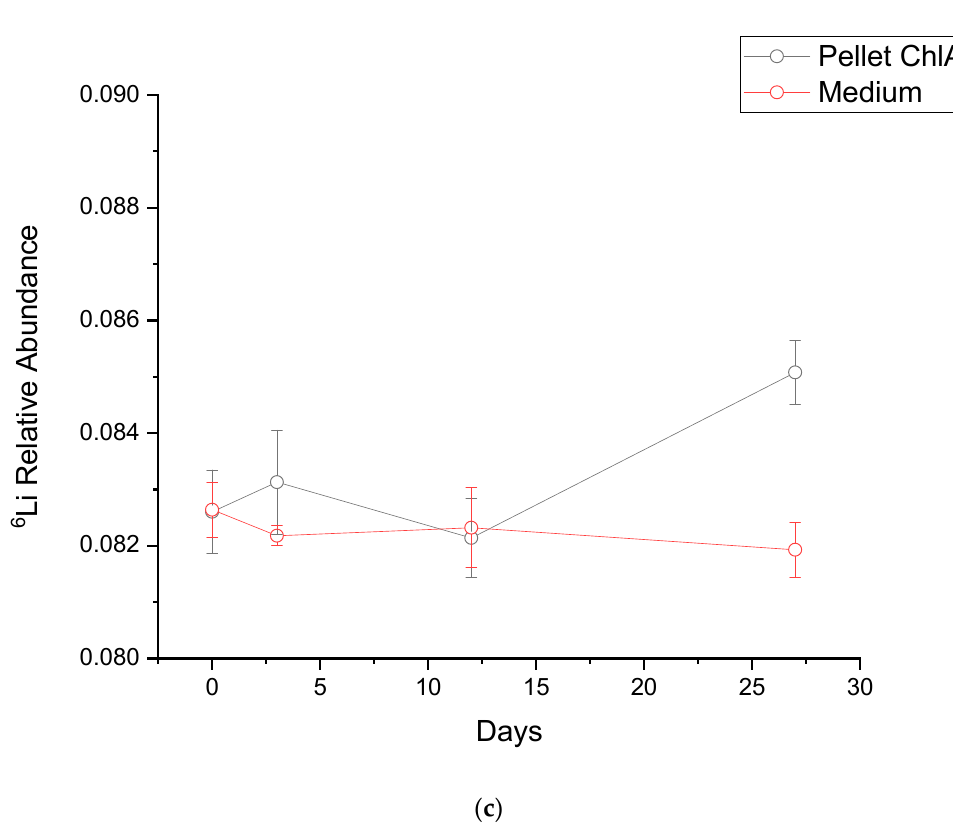
Figure 2. Isotopic relations for 6 Li analysed in the trials with strains ( a ) TmS1, ( b ) CAFE, and ( c ) ChlA, and the observed fractionation on days 0, 3, 12, and 27, respectively. Black circles correspond to the pellet’s isotopic relation, while red circles correspond to the media.